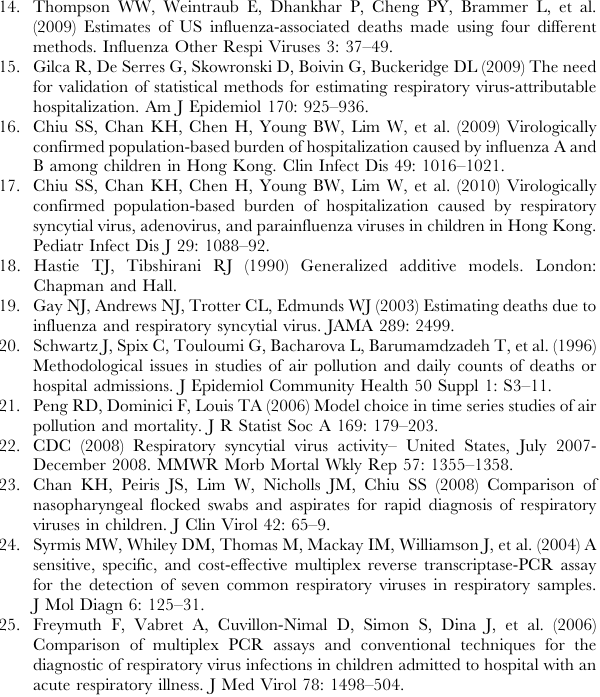
Figure S1 Proportions of specimens positive for com- mon respiratory viruses. Data were collected from the influenza surveillance network of Hong Kong Island in the study period.